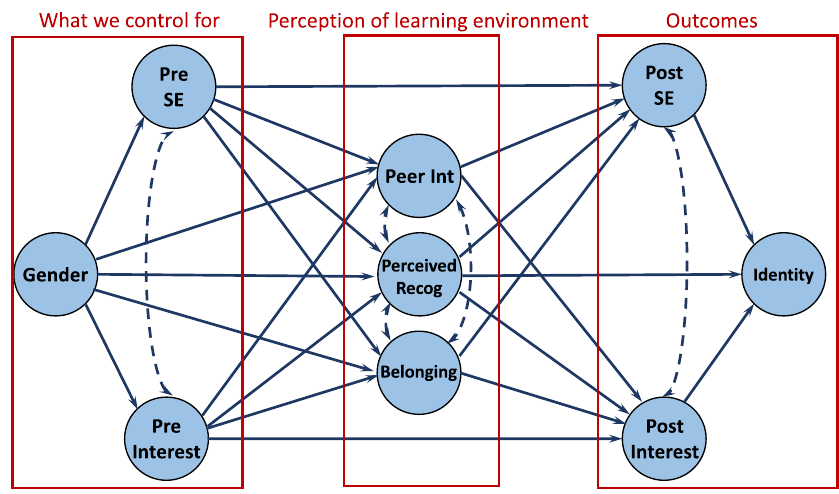
FIG. 1. Schematic representation of the theoretical framework regarding physics identity. From left to right, all possible regression paths were considered, but only some of the paths are shown